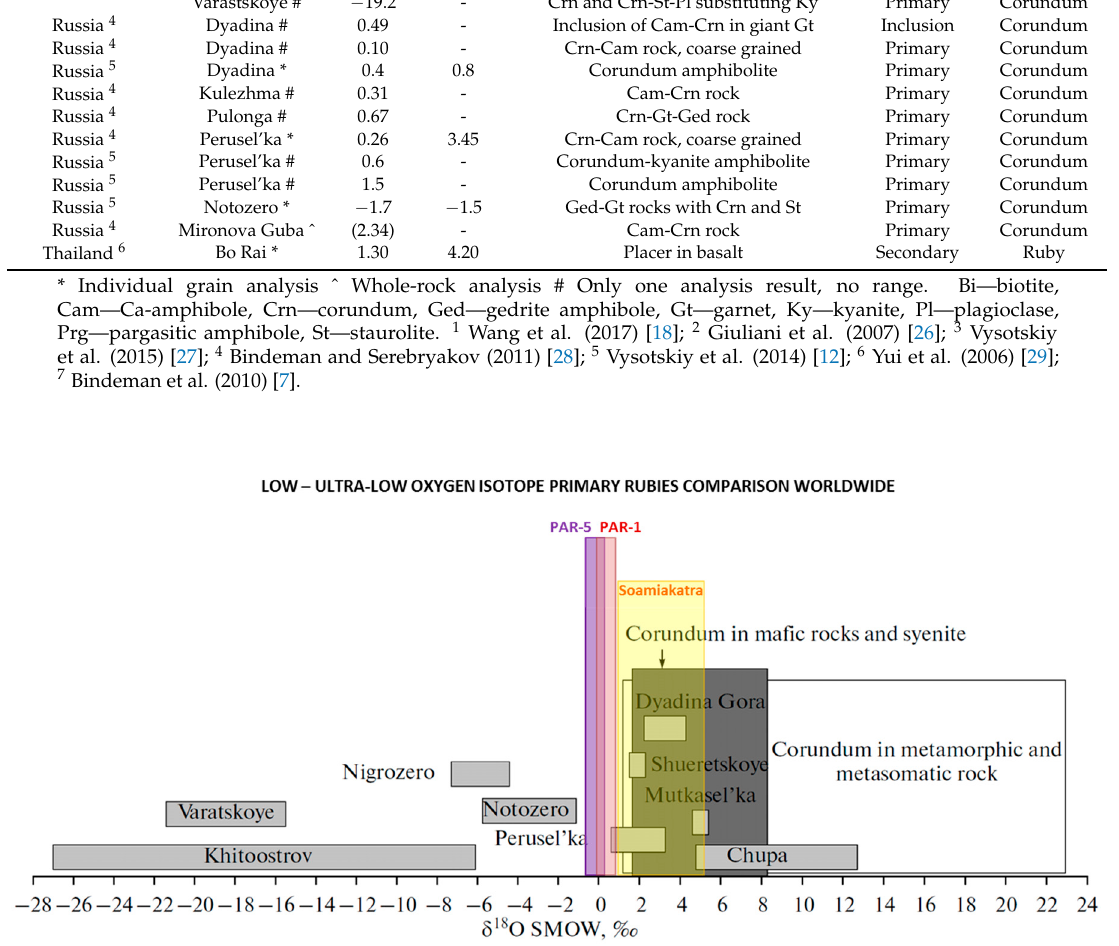
Figure 6. Oxygen isotopic comparison of rubies from Paranesti occurrences compared with low δ 18 O corundums from Karelia in northwestern Russia and Soamiakatra in Madagascar.